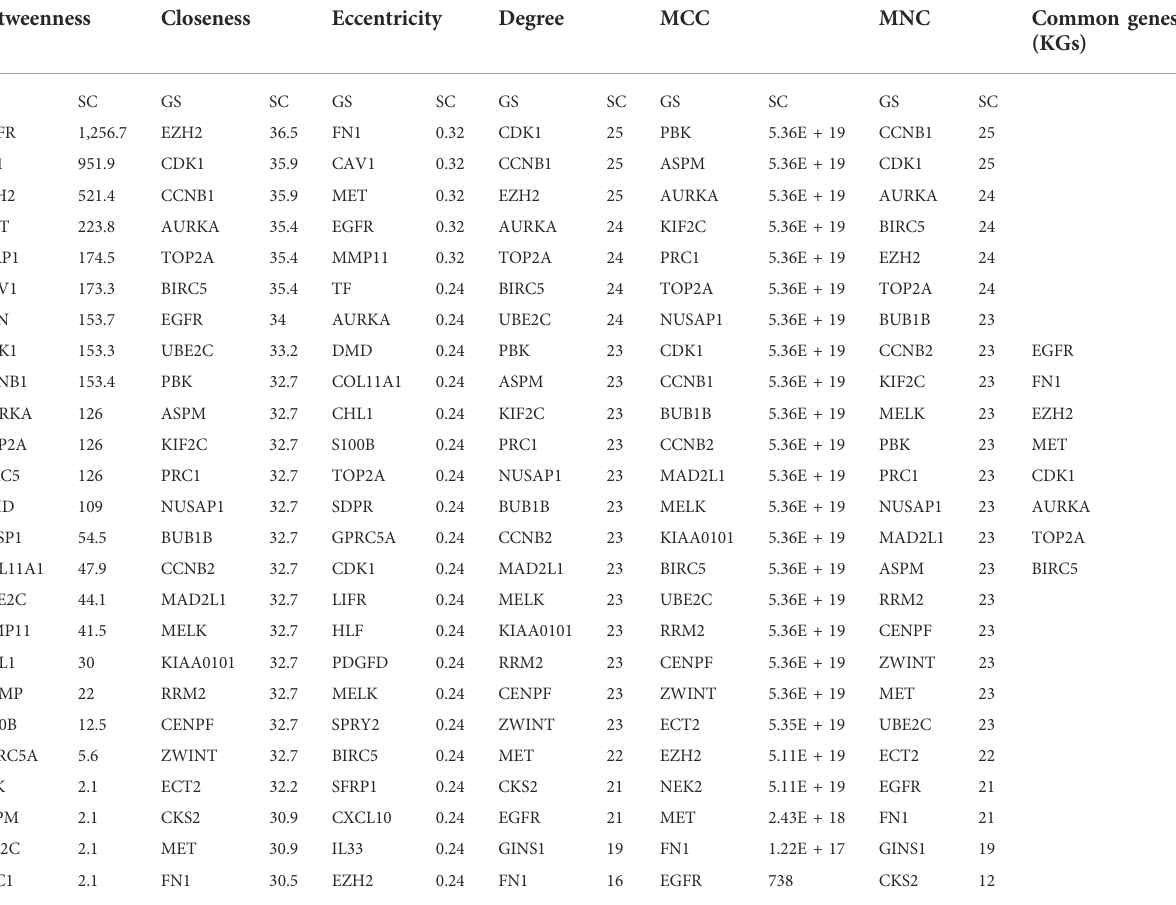
TABLE 3 Eight KGs were selected by taking the common of top 25 ranked genes for six network scoring measures through the PPI network. Betweenness Closeness